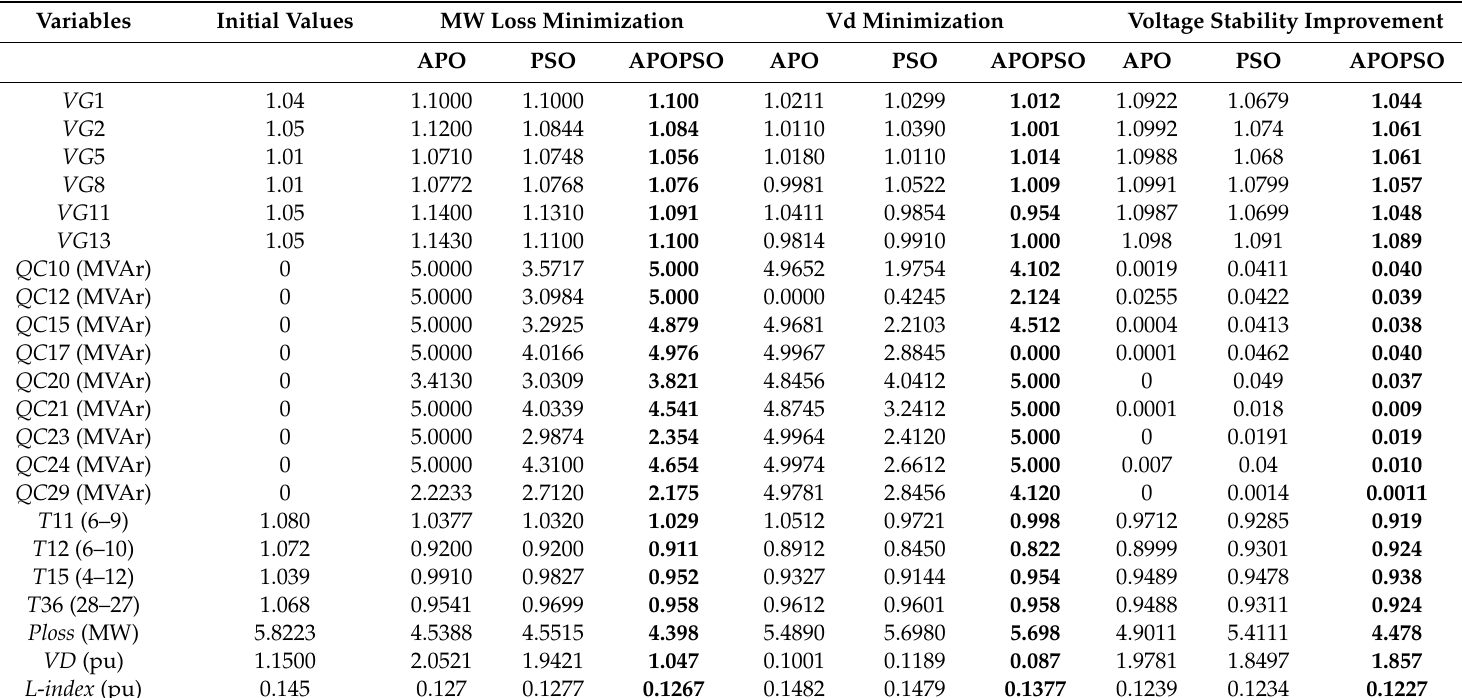
Table 2. Results obtained for the proposed algorithm on the IEEE 30 bus test